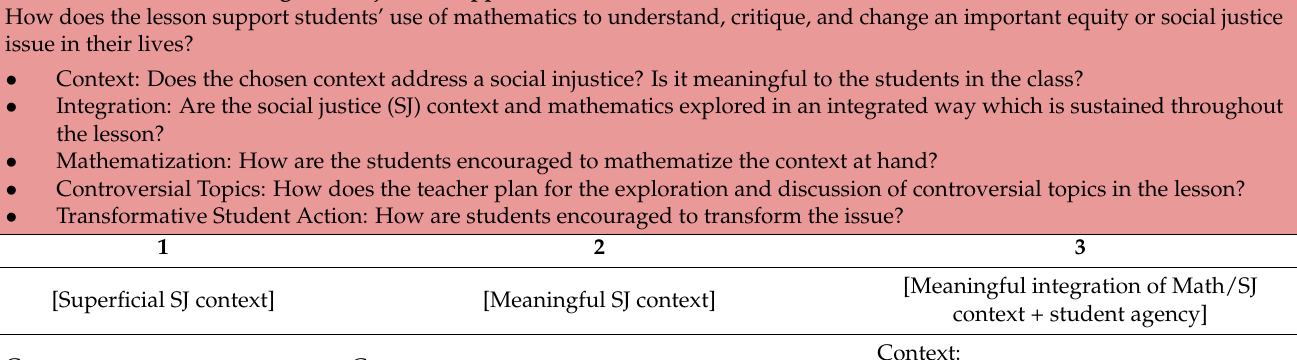
Table A2. PST CRMT-M lesson planning tool, social justice